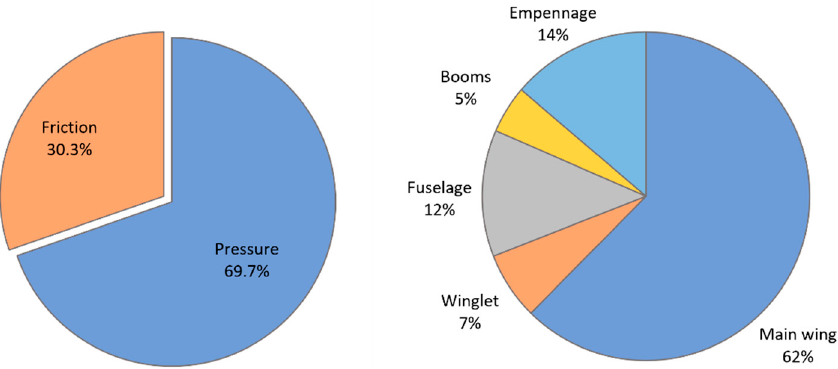
Figure 7. Breakdown of the UAV’s total drag ( left ) and contribution of each component to the friction drag ( right ).